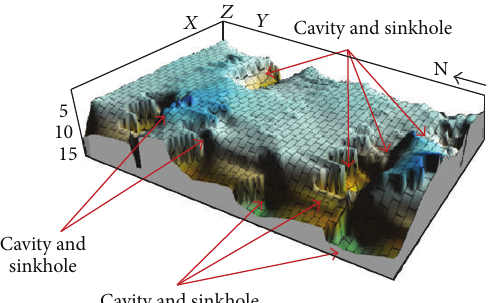
Figure 14: 3D representation of subsurface limestone in study